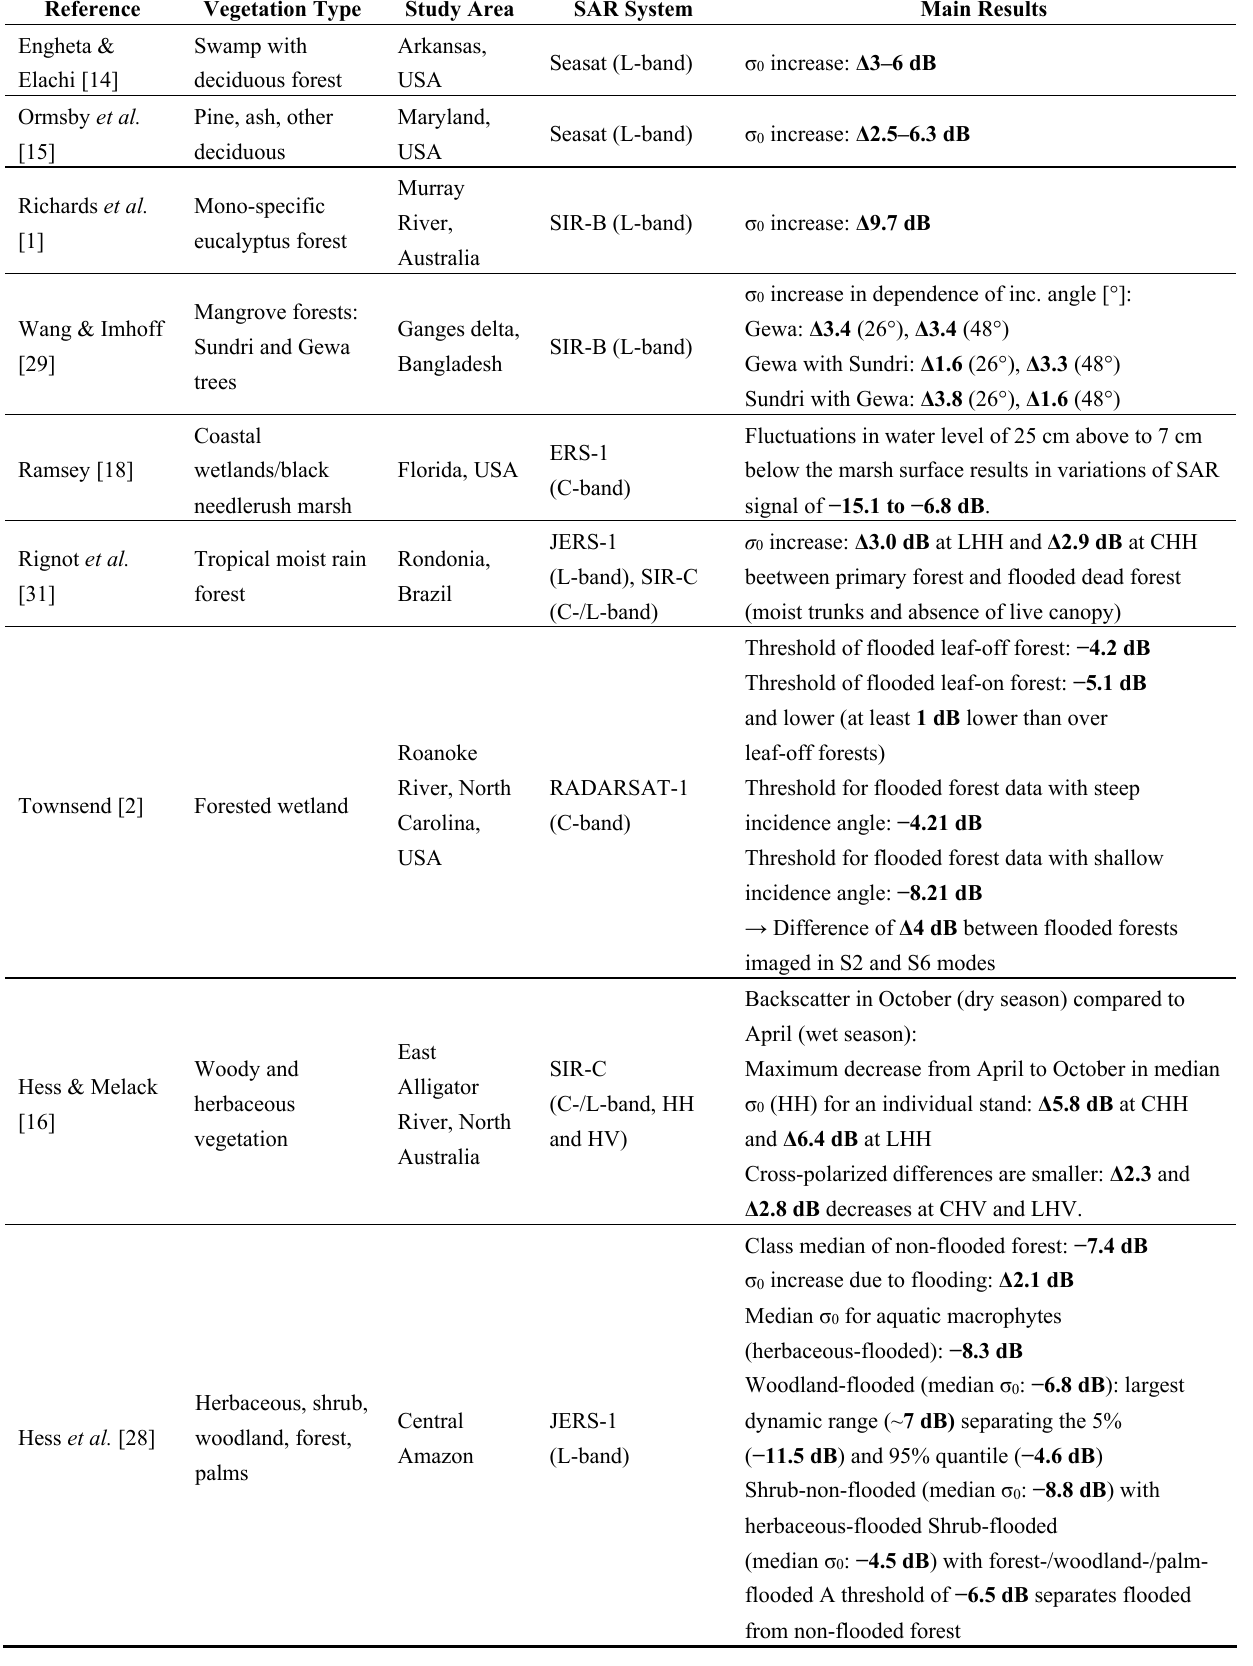
Table 1. Overview about the main findings in the literature concerning the mapping of flooded vegetation